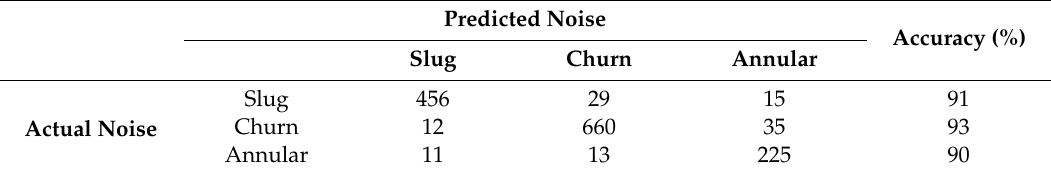
Table 4. Results from classification of refrigerant flow noise by